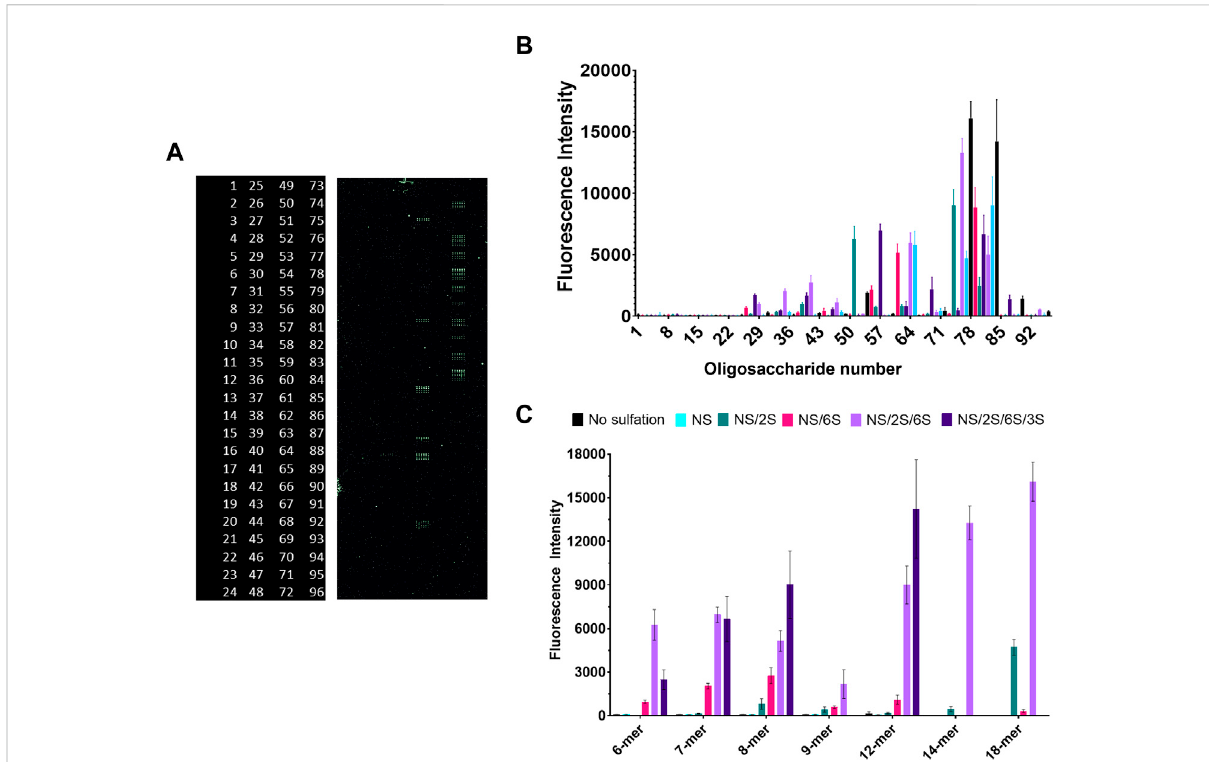
FIGURE 5 Glycan microarray illustrates the key role of 6- O - and 3- O -sulfation in gD/HS binding, while also revealing preference for longer-chain ligands with NS/6S/2S pattern that can be shifted to shorter chains if 3- O -sulfated. (A) Raw fl uorescent results of the glycan microarray and corresponding glycan code (numbered 1 – 96, glycan structures in Supplementary Figure S5). (B) Complete and (C) select results of gD285 binding to a glycan microarray andvisualizedwith OG488.Glycansplottedin C (from L → R) are(6-mers) 2,11,X, 29,51,80(7-mers)3, 15,53, 35,54,81